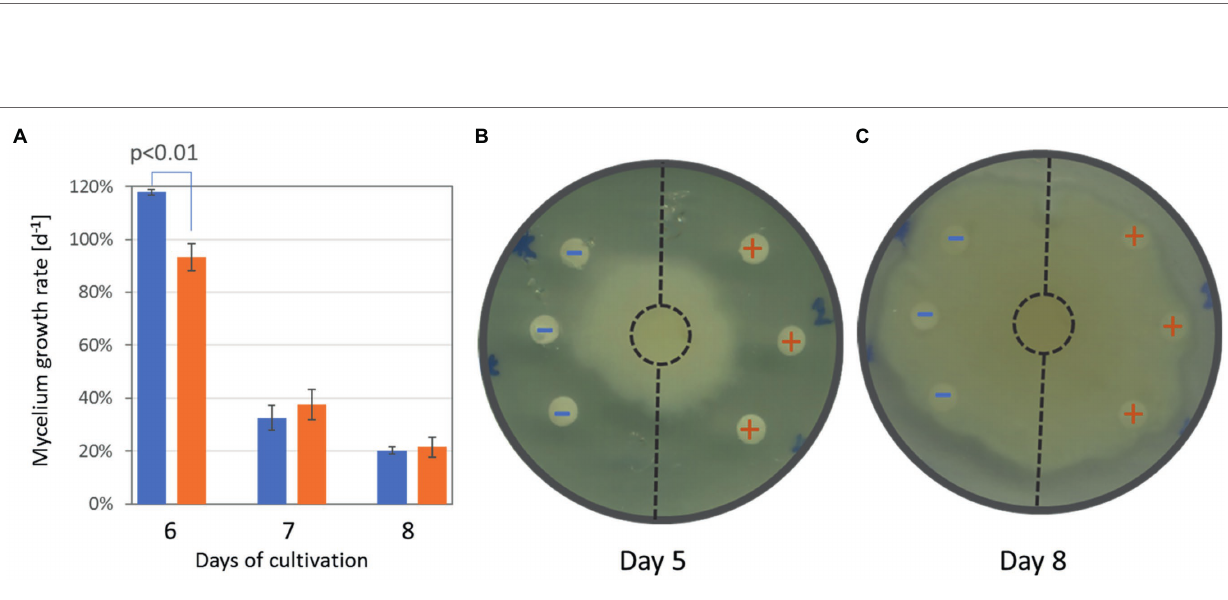
FIGURE 8 | Extracts from tubers of inoculated plants show significant inhibition of Phytophthora cactorum growth. (A) The comparison of mycelium growth and (B) representative images of the bioassay after five and 8 days of cultivation, respectively. Data represent the means and standard deviation of three biological replicates. Blue ( − )—extracts from mock-treated plants; Orange (+)—extracts from inoculated